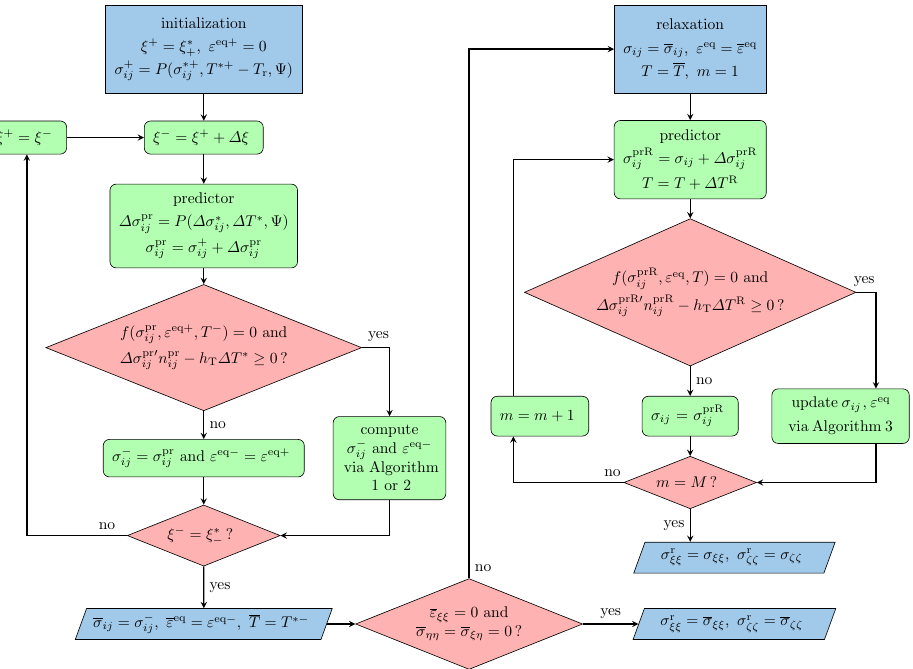
Figure 3. Flow chart for the residual stress